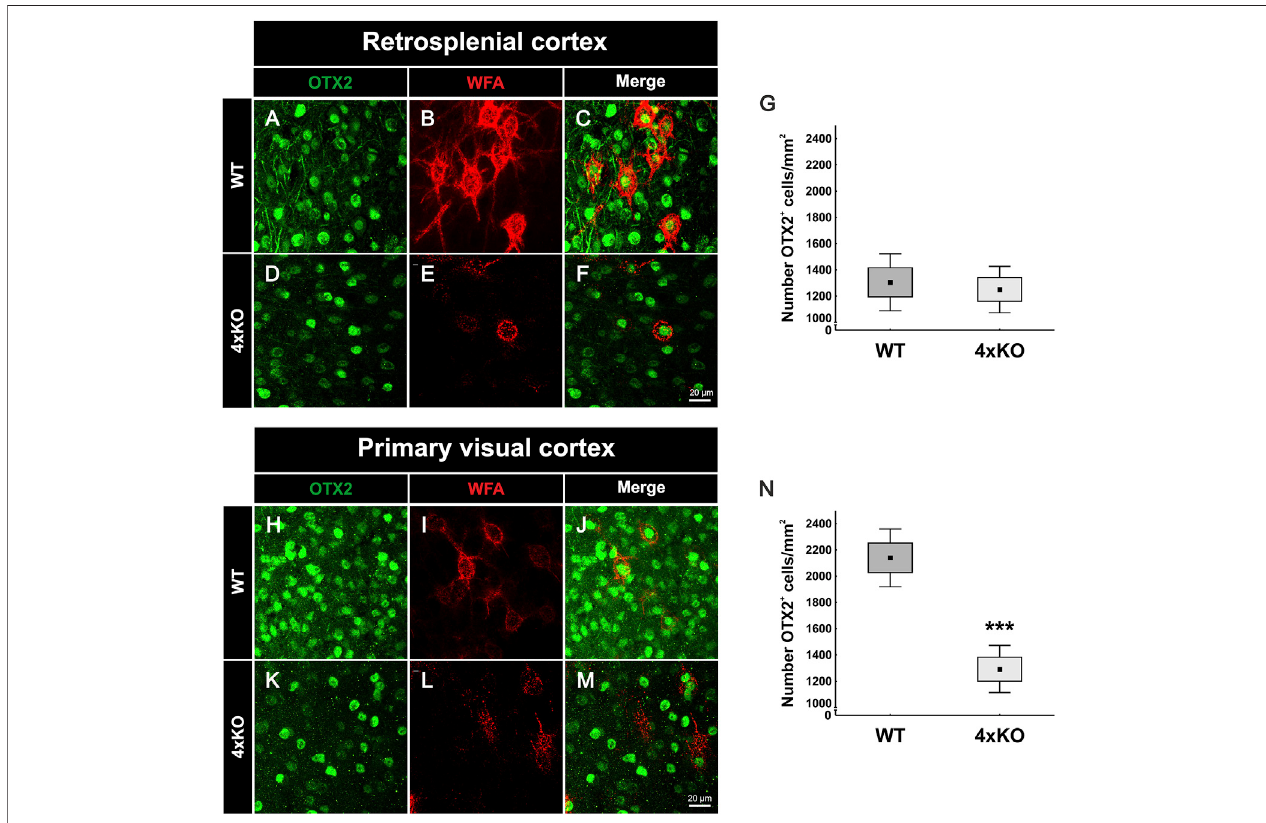
FIGURE 6 | Expression of Otx2 in the cerebral cortex of wildtype and quadruple knockout mice. (A-F, H-M) Representative images of Otx2-positive cells (green) andWFA-positivePNNs(red)intheRSCandV1ofwildtypeandquadrupleknockoutmice.PNN-enwrappedneuronsandalsoothercellsshowedOtx2accumulationat the soma. (G) Counting of Otx2-positive cells in the RSC revealed a comparable number in wildtype and quadruple knockout tissue ( p = 0.7, N = 8). (N) In contrast, statistical evaluation of Otx2-positive cells in the V1 showed a strong reduction in the number of Otx2-positive cells of quadruple knockout mice in comparison to the wildtype ( p < 0.001, N = 8). 4xKO, quadruple knockout; Otx2, orthodenticle homeobox 2; RSC, retrosplenial cortex; V1, primary visual cortex; WFA, Wisteria fl oribunda agglutinin; WT, wildtype, *** p < 0.001 data are shown as mean ± SEM and SD, scale bars A = 20 µm.